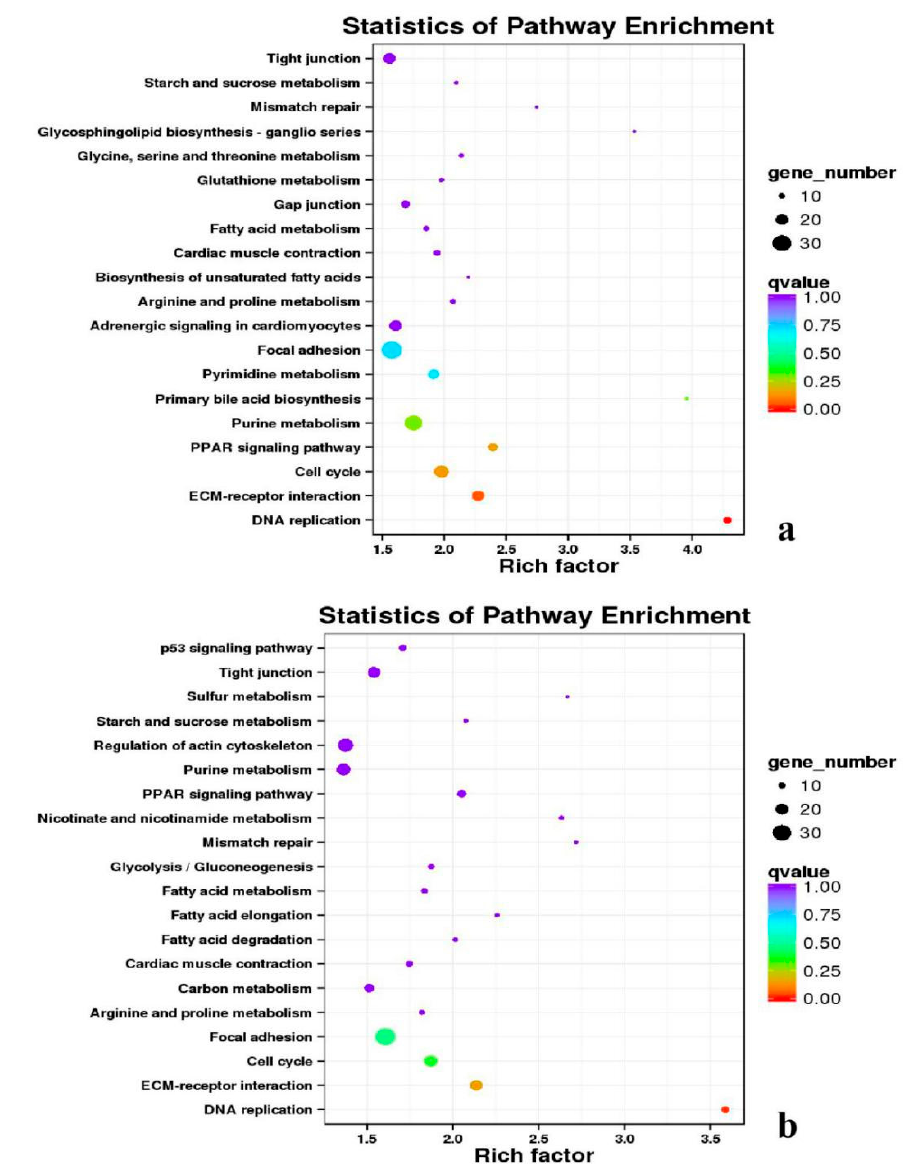
Figure 13. KEGG annotation of DEGs in breast muscle. ( a ) BE17B_vs_BE31B; ( b ) BE17B_vs_BE34B.